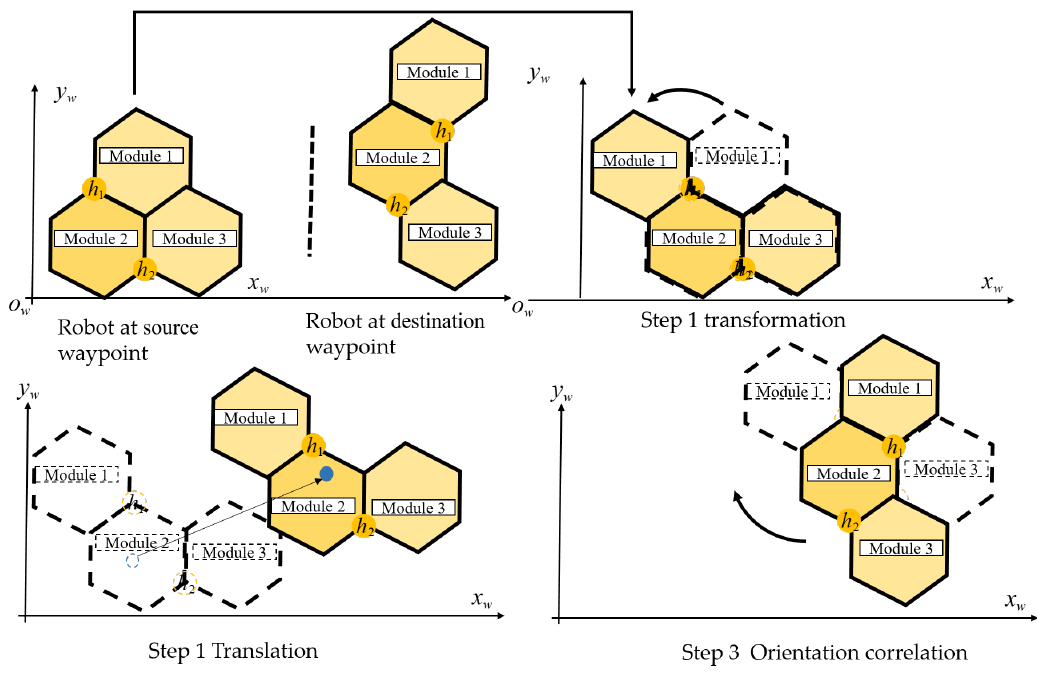
to a goal waypoint W d k